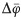
Analysis of cell morphology by digital holographic microscopy.Analysis of cell morphology by evaluation of quantitative phase images retrieved with digital holographic microscopy: (a) Histograms of quantitative DHM phase contrast images at different time points for control cells and cells treated with capsaicin and the different nanoformulations. (b) Average phase contrast Δφ¯ for all treatments plotted over time with a linear fit. (c) Slopes and Y-intercepts retrieved by the linear fits from (b). Mean values ± SD (n = 3).